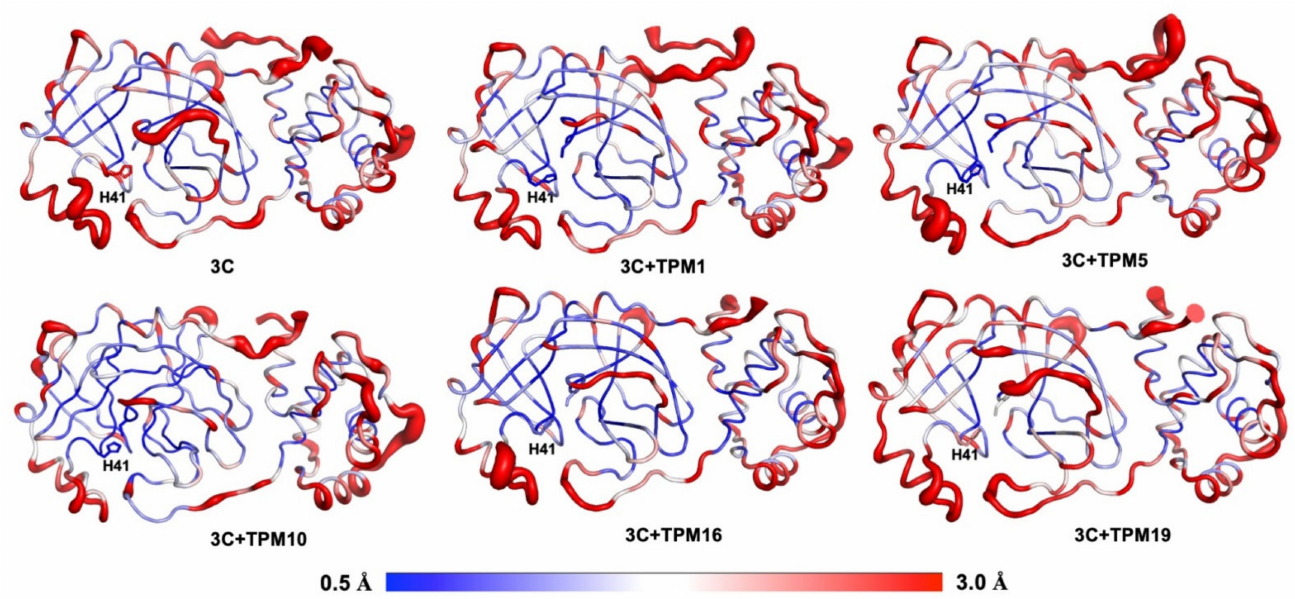
Figure 5. Conformational plasticity of 3CL Pro and 3CL Pro –TPM complexes. The red bulges indicate flexible regions, while the blue colored regions were relatively rigid. TPMs 1, 5, and 10 significantly reduced the flexibility of the H41